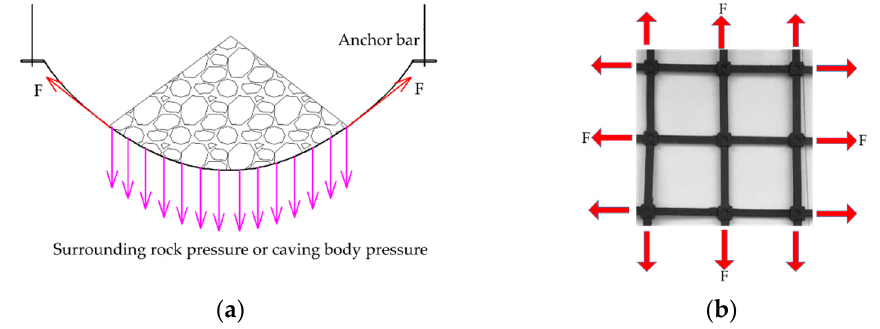
Figure 2. The tensile stress analysis of steel–plastic compound geogrid in an anchor mesh support: ( a ) stress analysis chart of the anchor mesh support; ( b ) tensile stress analysis chart of the steel–plastic compound geogrid.